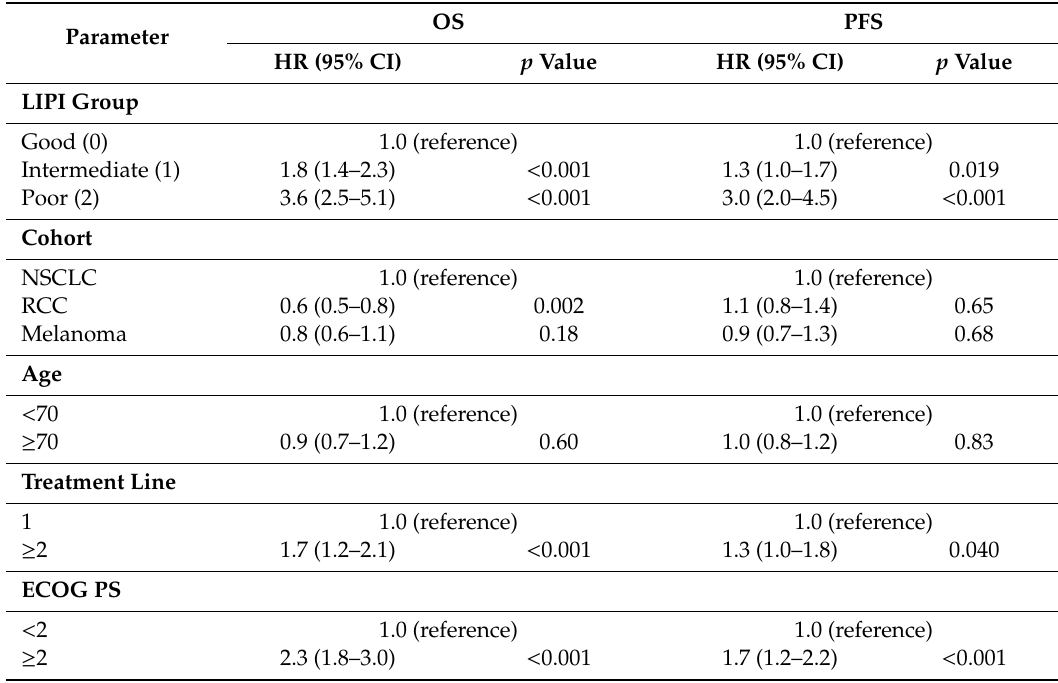
Table 2. Multivariate analysis of factors associated with overall survival (OS) and progression-free survival (PFS) in the pooled cohort.